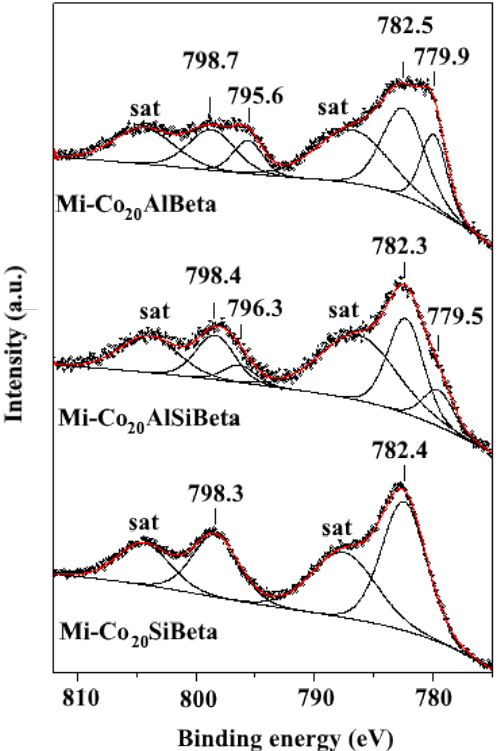
Figure 4. Co 2p photoelectron spectra of microporous Co 20 Beta zeolites.